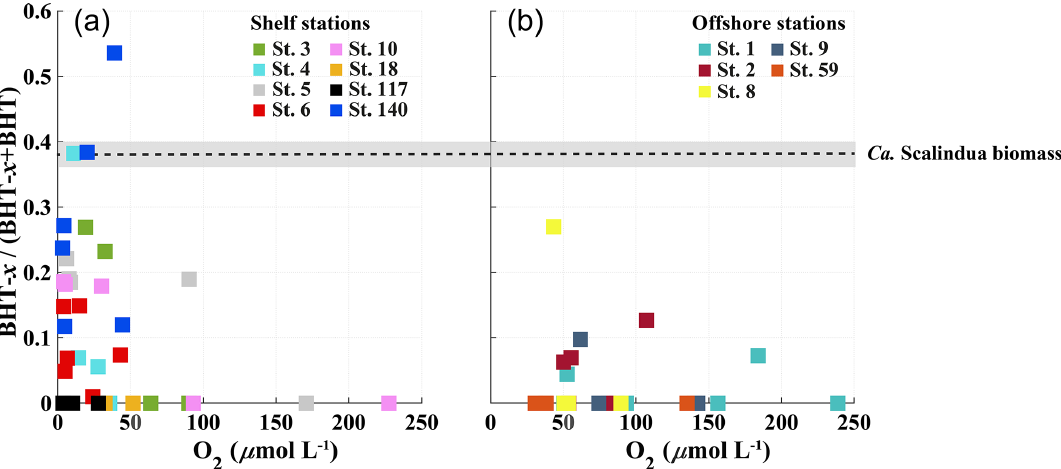
Figure 6. Scatter plots showing relationship between BHT- x ratio (BHT- x / (BHT + BHT- x ) and oxygen concentration (µmolL − 1 ) for stations located on the shelf (a) and stations located offshore (b) . The BHT- x ratio observed in the Ca. S. brodae enrichment culture is indicated with the black dotted line at 0.38. The grey area corresponds to the standard deviation of the ratio ( ± 0.02) between different HPLC/MS